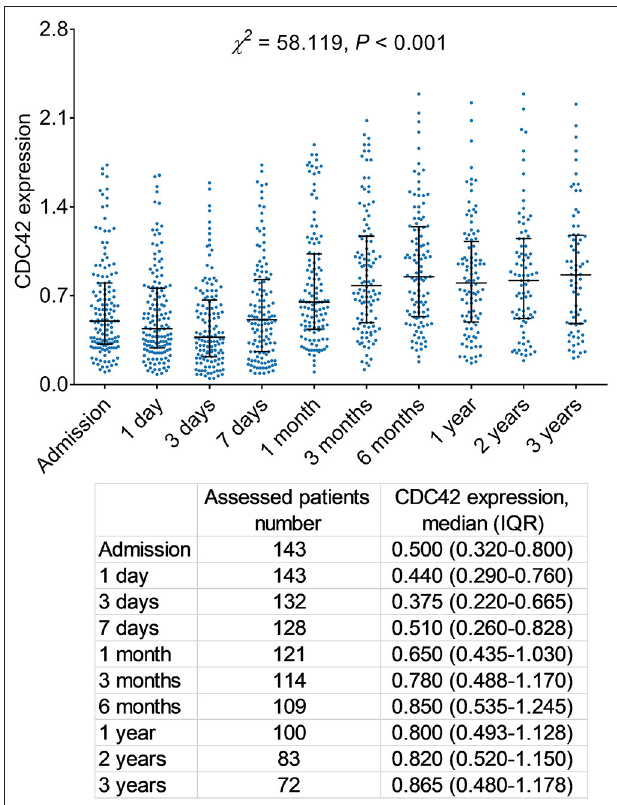
FIGURE 5 | Differences of CDC42 at different time points after AIS